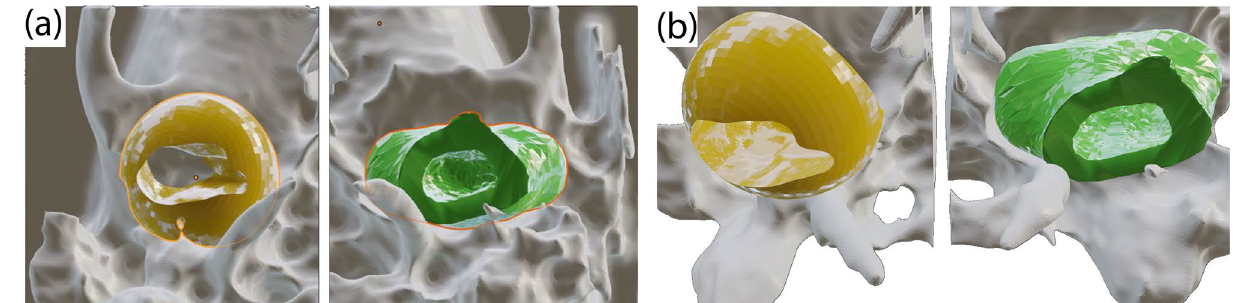
Figure 4. Proposed manually annotated (yellow) versus machine-generated (green) negative volumes. Rendered regions of the TB are shown in gray. Views: ( a ) axial, from bottom ( b ) same, tilted. Figure created with Incscape v.1.1, https:// inksc ape.